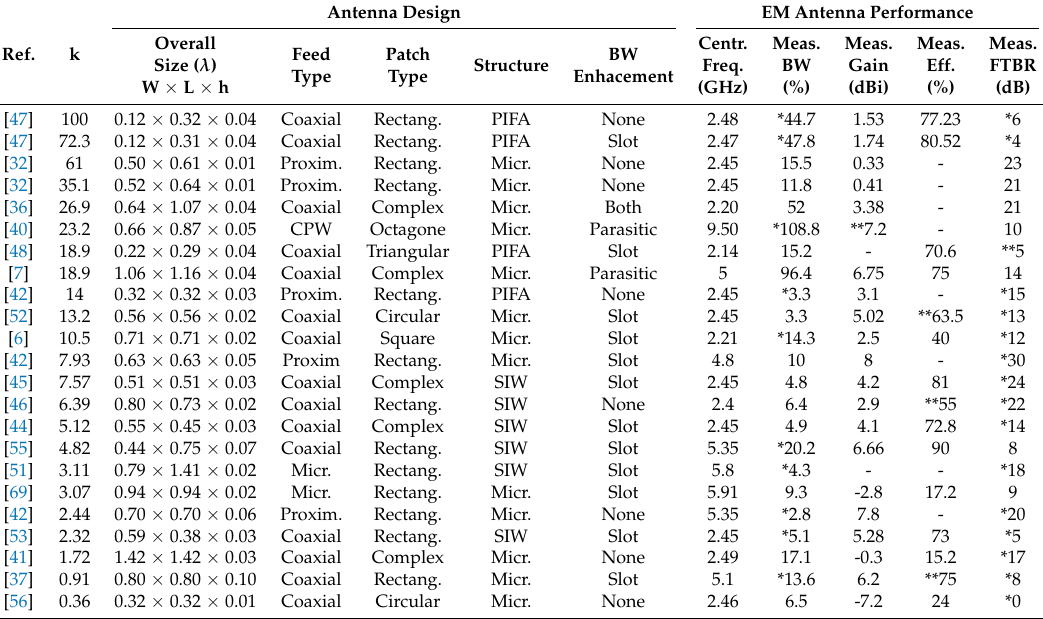
Table 1. Textile antenna’s design vs. electromagnetic (EM) performance. Antenna